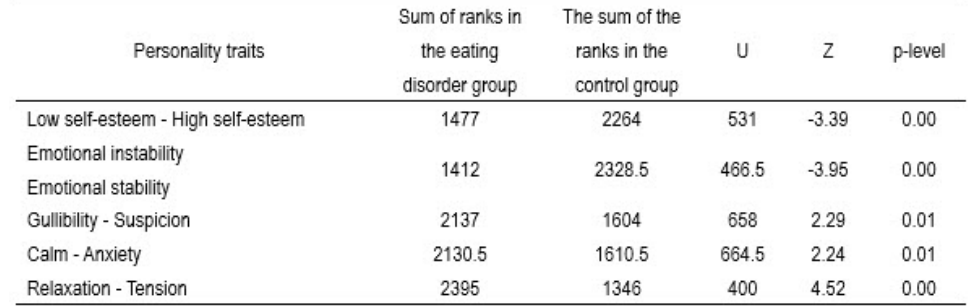
Comparative analysis of personality traits of individuals with eating disorders and individuals from the control group (Mann-Whitney U